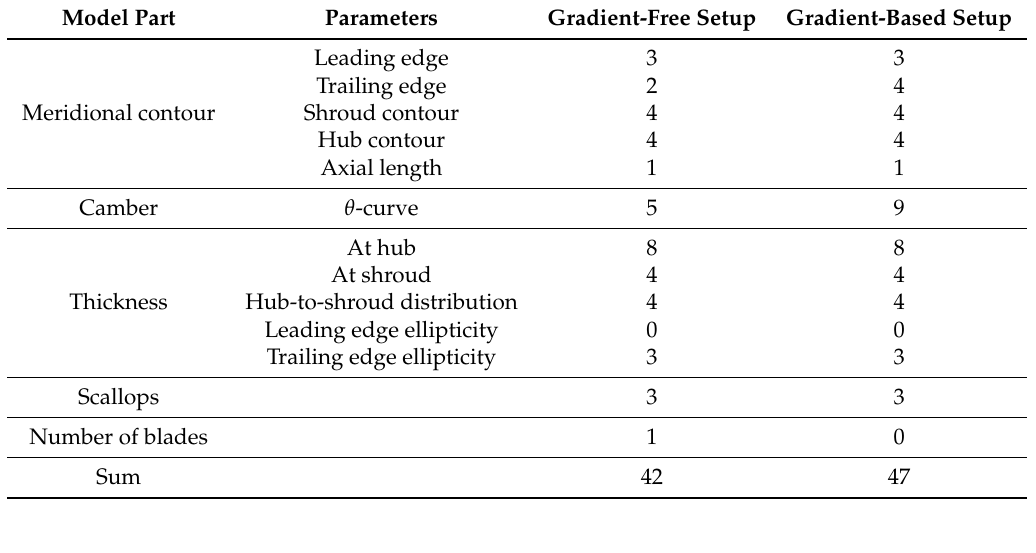
Table 1. Variable parameters for gradient-free and gradient-based setup